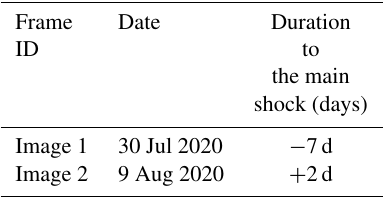
Table 3. Sentinel-2 optical images collected for the study